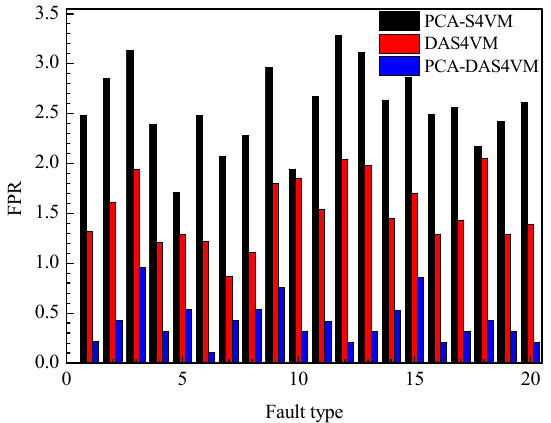
Figure 11. False positive rate (FPR) for PCA-S4VM, DAS4VM, and PCA-DAS4VM models.